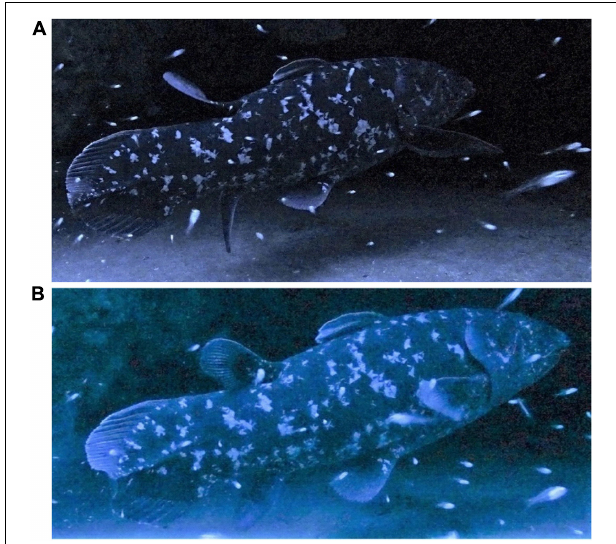
FIGURE 6 | Photographs of the coelacanth in the cave with its first dorsal fin folded when there were no sharks or other predatory fishes nearby, which appear to represent the resting state of the fish (A,B)